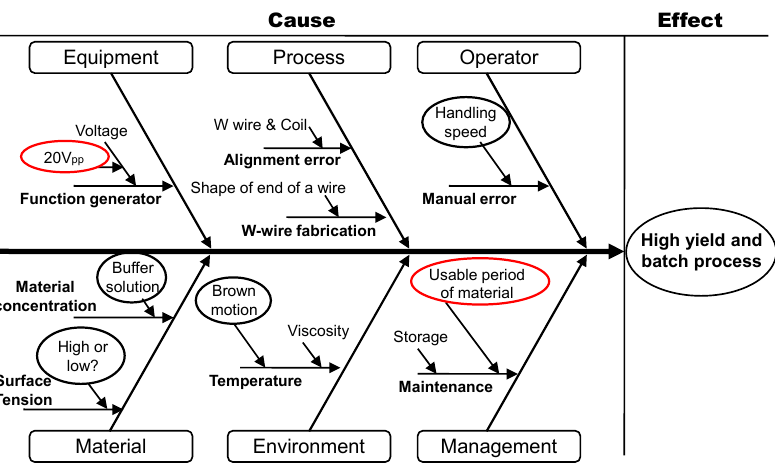
Figure 4. Cause and effect diagram in the Analyze phase for a dendritic nanotip sensor. Equipment, process, operator, material, environment, and management are analyzed to improve yield and scalability. Among them, the red-circled contents of voltage and material usability are investigated in the paper.